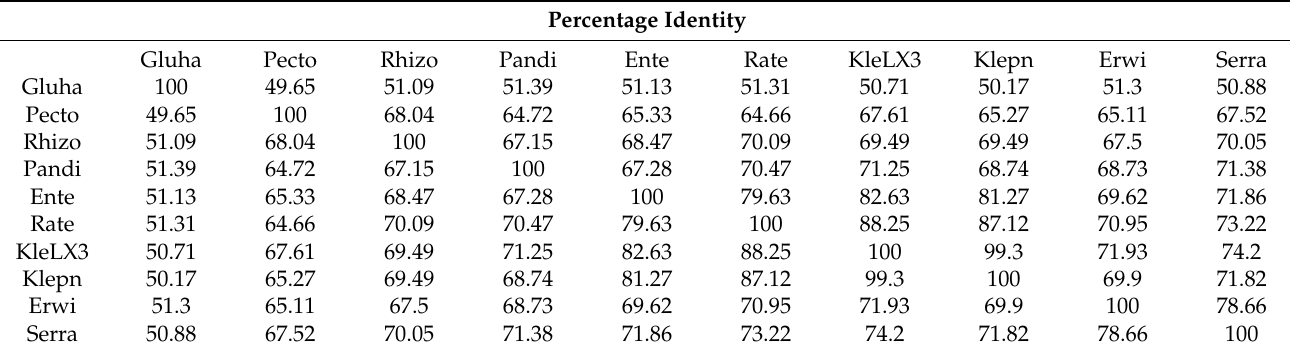
Table 2. Comparison of the amino acid sequences of identified SIases from different microorganisms.